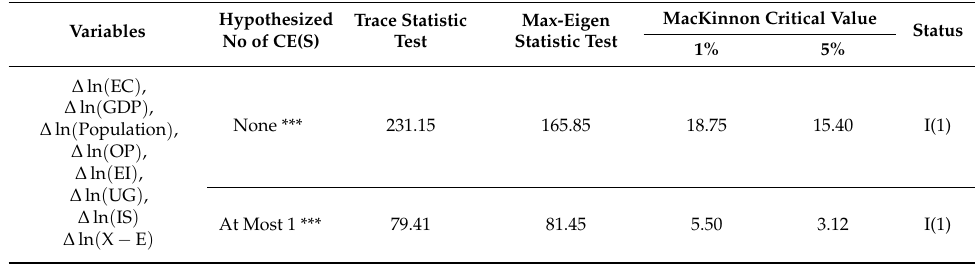
Table 2. Co-integration test by Johansen Juselius.